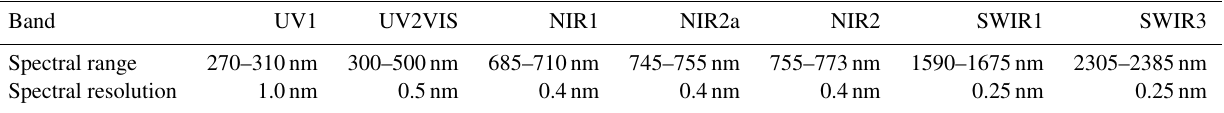
Table 2. Characteristics of S5/UVNS spectral bands. Band